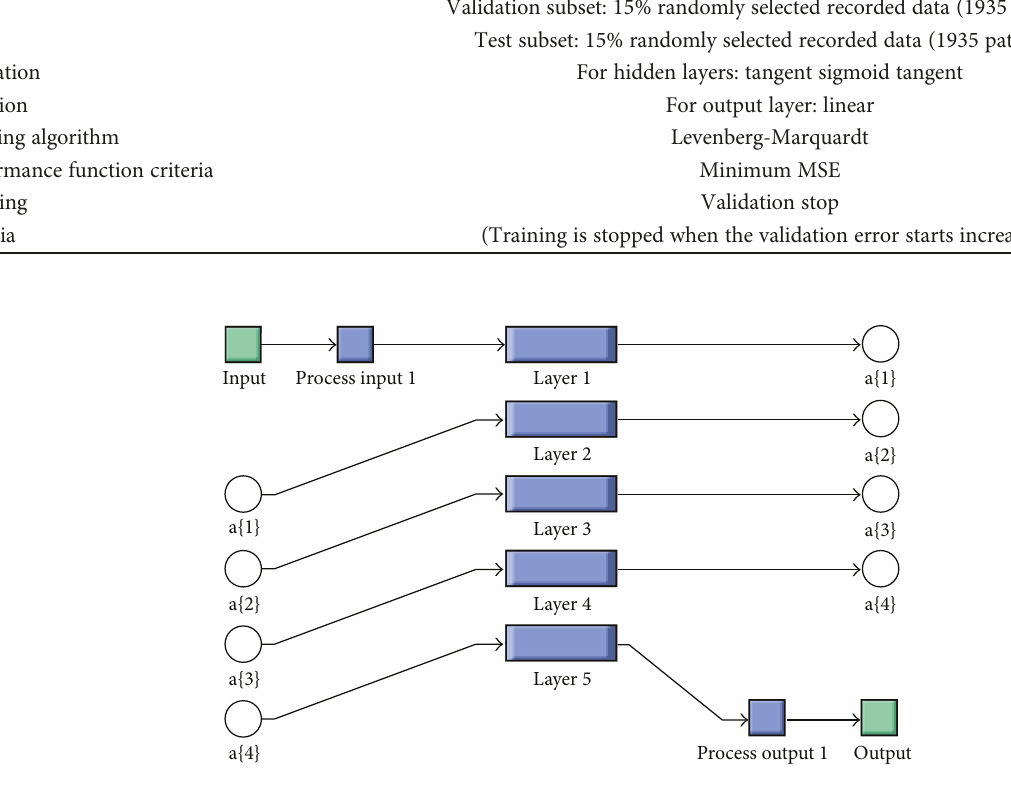
Figure 9: Modelling of the developed ANN model in MATLAB Simulink environment.